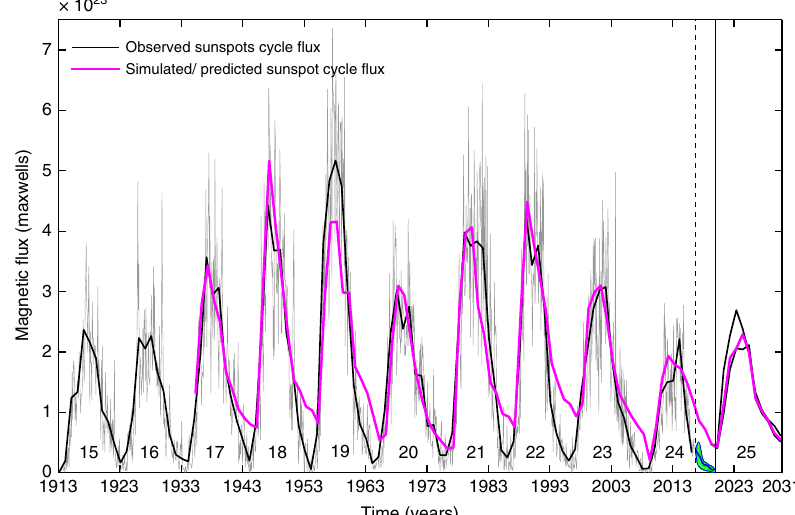
Fig. 4 Prediction of sunspot cycle 25. Solar dynamo simulated sunspot cycles (magenta curve) compared with the observed sunspot cycle (unsigned magnetic fl ux; black curve), where both quantities are yearly averaged. The light gray curve in the background represents monthly averaged unsigned sunspot fl ux. The blue and set of green curves between the vertical black dashed and solid lines depict fl ux associated with the thirty-four synthetic pro fi les used in the surface fl ux transport model as plausible realizations of the descending phase of cycle 24. The magenta curve beyond the solid-black vertical line (corresponding to our standard simulation) depicts the predicted shape and strength of sunspot cycle 25. The set of two black curves beyond the solid- black vertical line represent the strongest and the weakest magnetic cycles (that is the range of our ensemble forecast) based on our diverse predictive dynamo runs. The prediction range (uncertainty) indicates cycle 25 will be similar or slightly stronger than the previous cycle